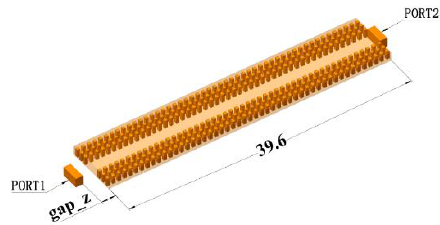
Figure 4. Simulation model for the study of the influence of gap_z on transition performance.